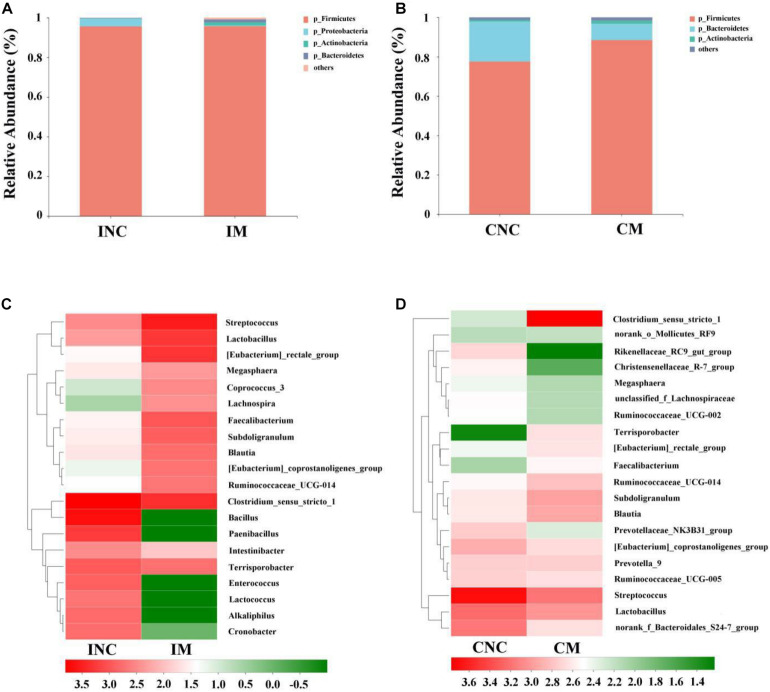
Bacterial diversity at the phylum and genus level in the ileum and colon from weaned piglets of control and treatment group. (A) Bacterial community barplot of INC and IM at the phylum level in ileum. (B) Bacterial community barplot of CNC and CM at the phylum level in colon. (C) Bacterial community barplot of INC and IM at the genus level in ileum. (D) Bacterial community barplot of CNC and CM at the genus level in colon. INC, ileum negative control; CNC, colon negative control; IM, ileum with 0.2% montmorillonite; CM, colon with 0.2% montmorillonite.